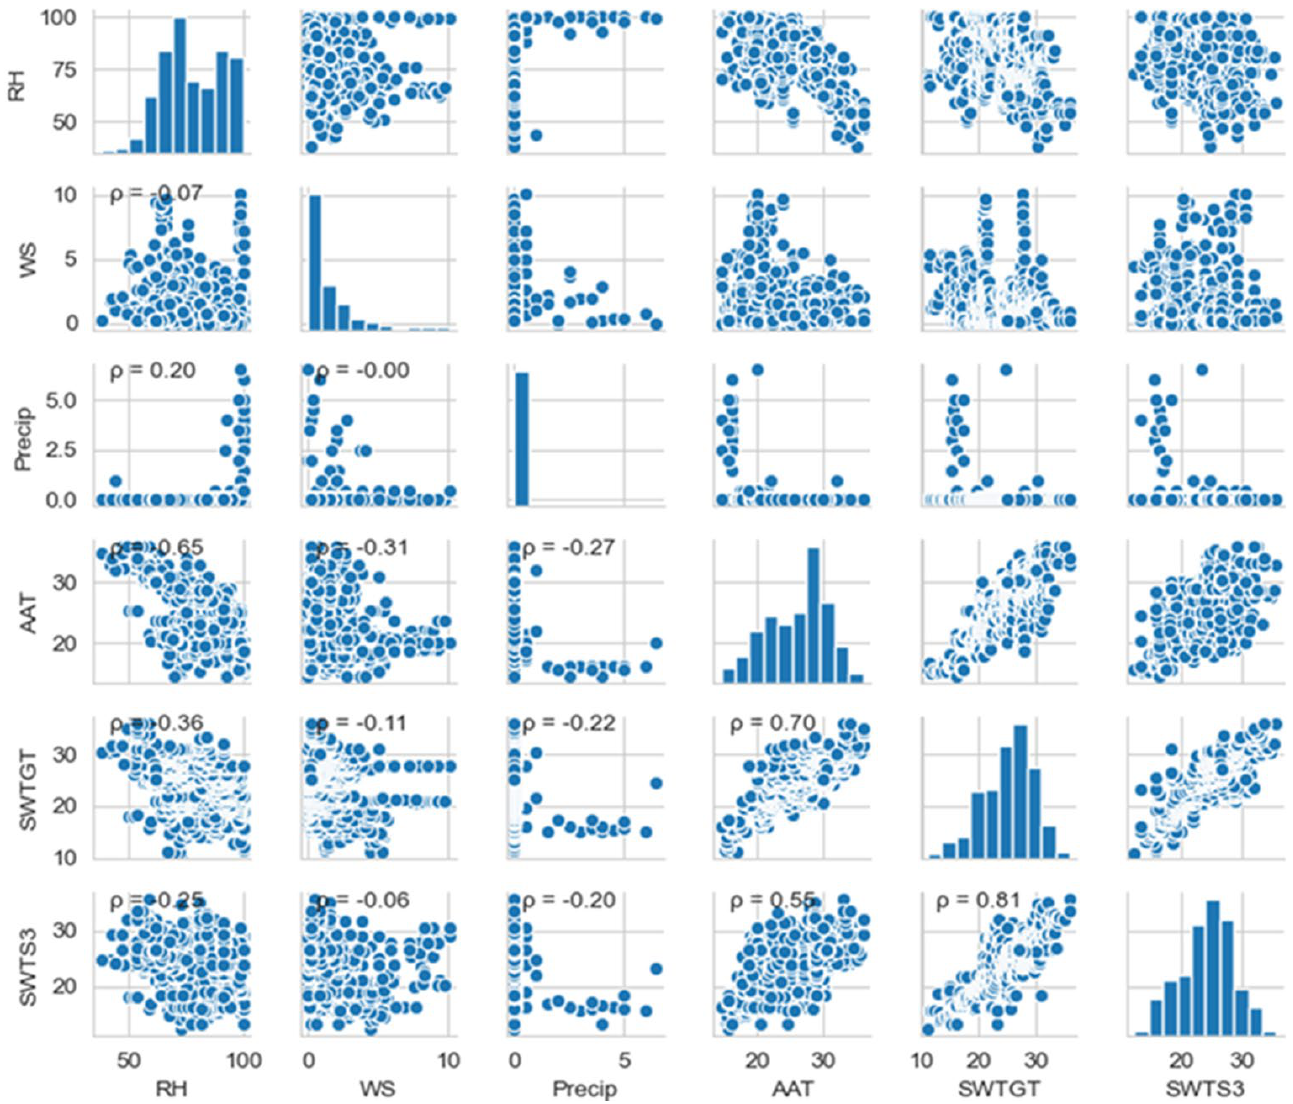
Figure 7. Correlation matrix for the different variables highlighting pairwise numerical value of ρ, scatterplots, while the diagonal bar charts represent a data distribution pattern for each variable.